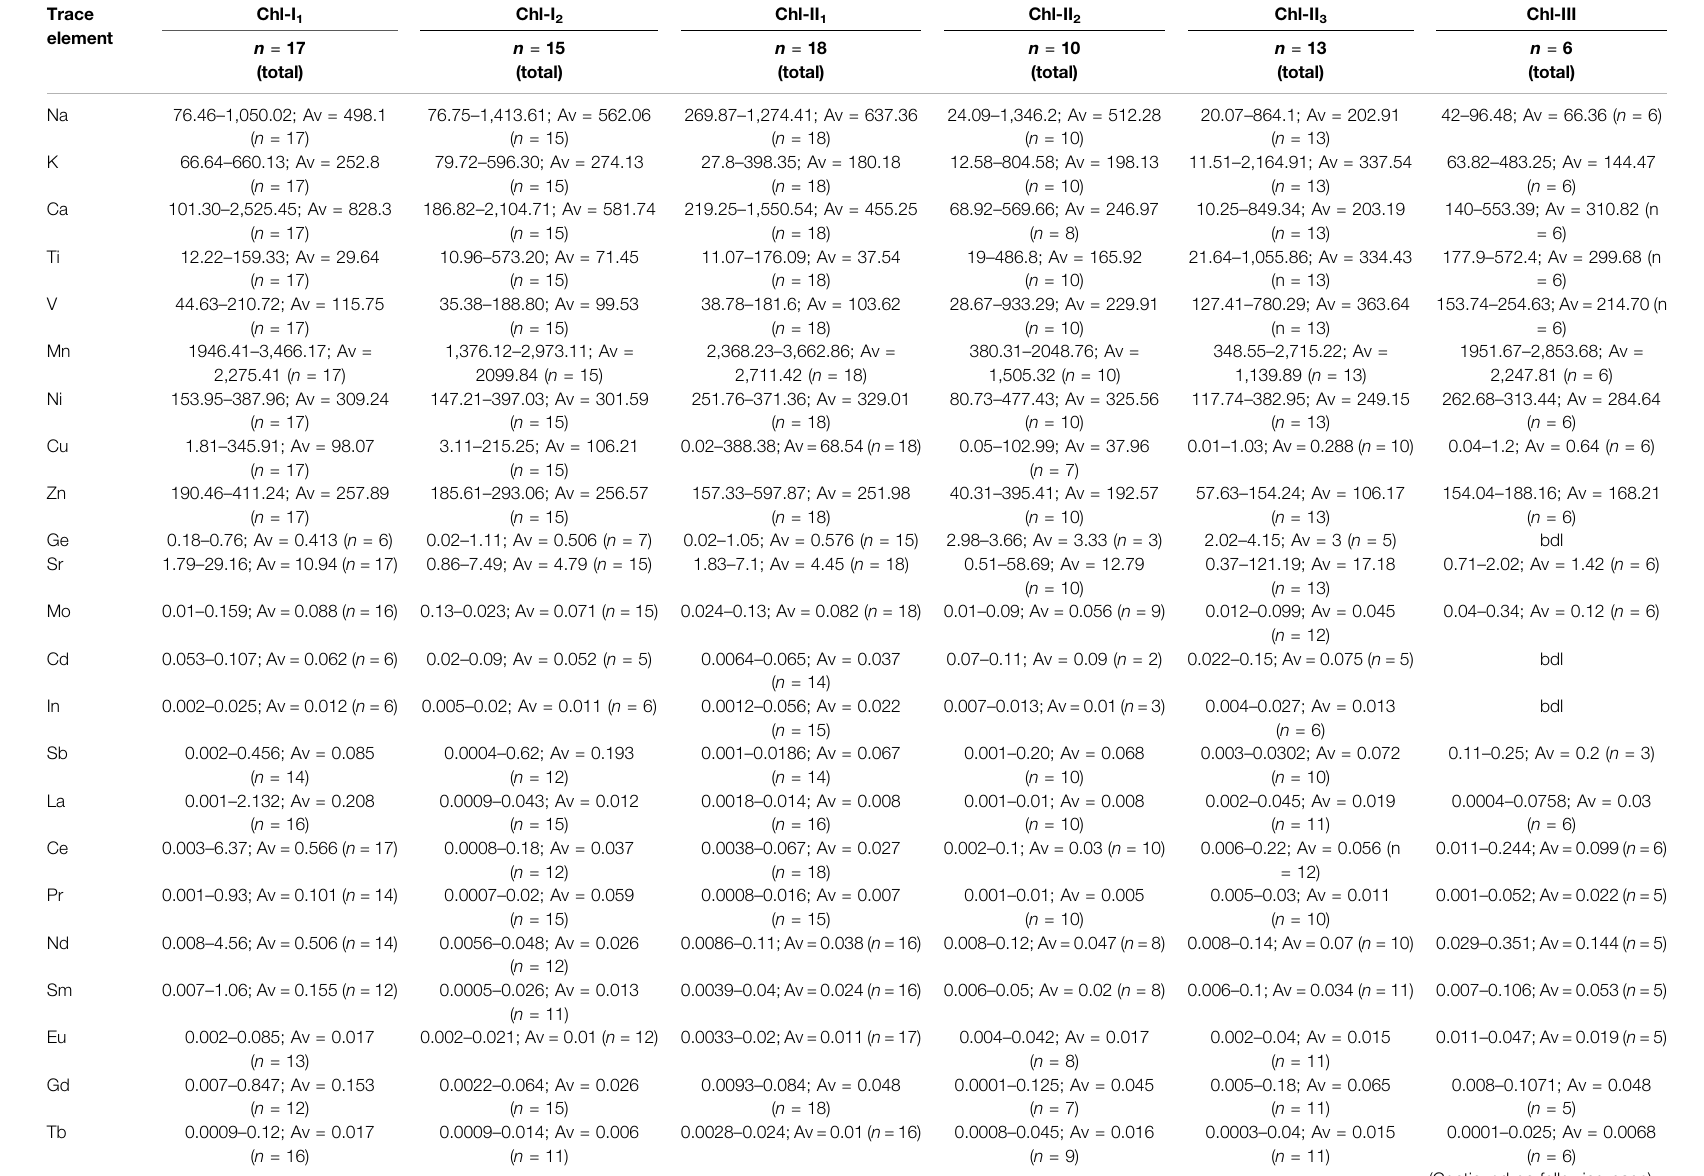
TABLE 2 | In situ trace element composition and characteristic REE values of chlorite for different metallogenic stages of the Tuwu porphyry Cu deposit in eastern Tianshan, Xinjiang, NW China